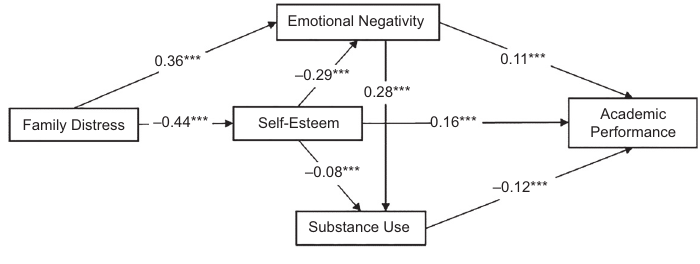
Figure 2. Final model